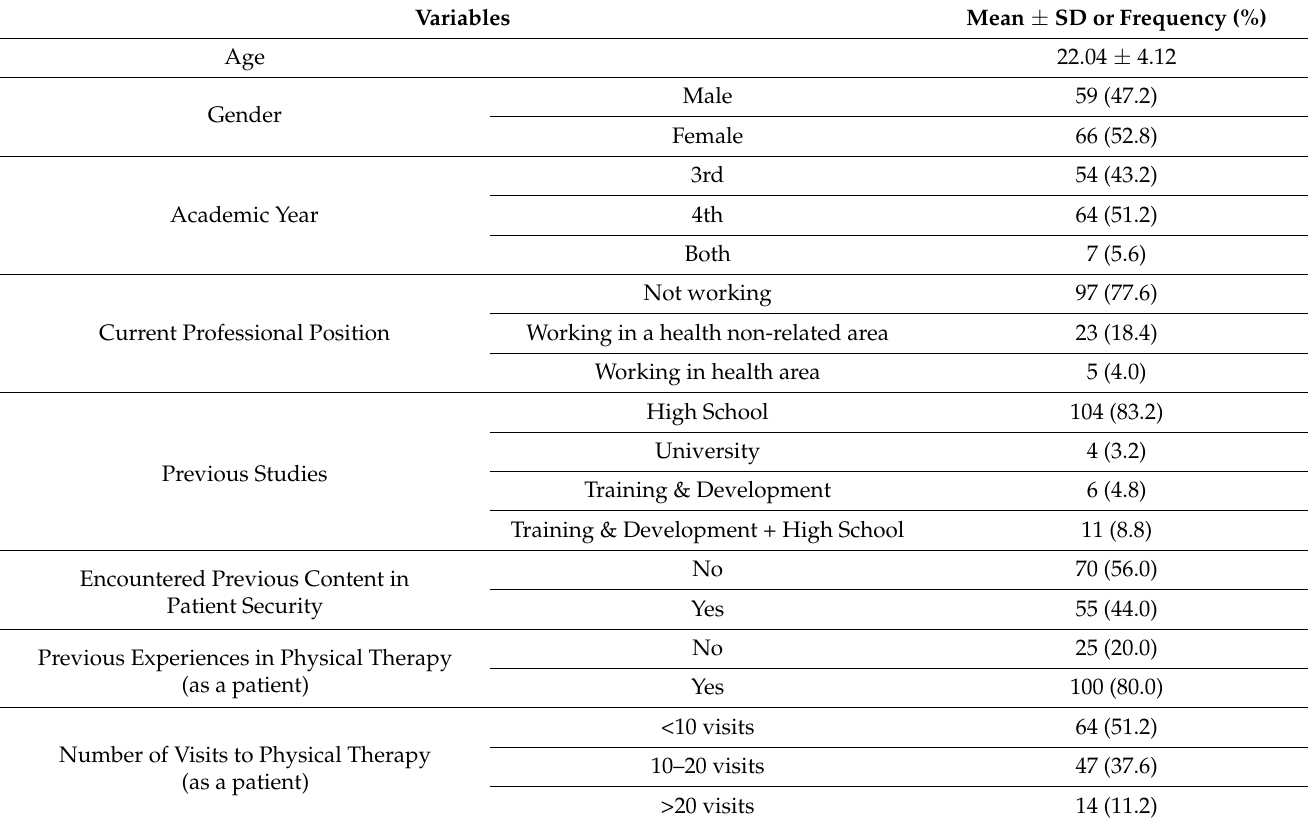
Table 1. Participants’ characteristics at baseline ( n =